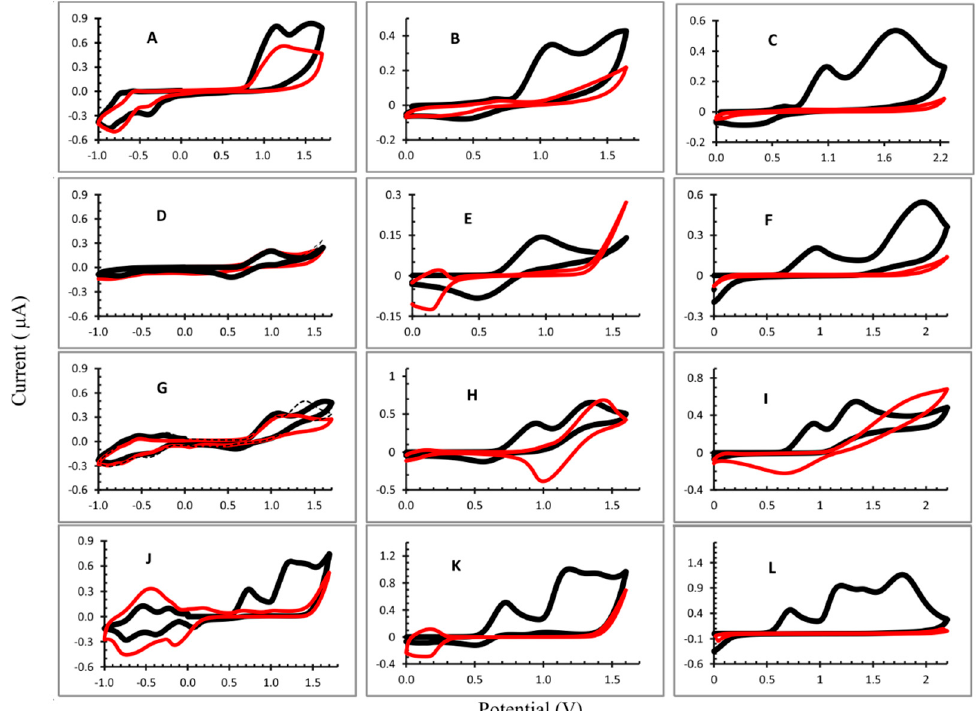
Figure 2. Cyclic voltammograms recorded during electropolymerization: ( A ) OEP 1 ; ( B ) OEP 2 ; ( C ) OEP 3 ; ( D ) CuOEP 1 ; ( E ) CuOEP 2 ; ( F ) CuOEP 3 ; ( G ) NiOEP 1 ; ( H ) Ni OEP 2 ; ( I ) Ni OEP 3 ; ( J ) ZnOEP 1 ; ( K ) ZnOEP 2 ; and ( L ) Zn OEP 3 . Potential range: 1 : − 1.0 V to 1.7 V; 2 : 0.0 V to 1.6 V; and 3 : 0.0 V to 2.2 V. 1,2-C 2 H 4 Cl 2 with 0.1 mol L − 1 TBAP and 4 mmol L − 1 bpy. Working electrode: ITO; scan rate: 0.1 V s − 1 . Black line: first cycle and red line: 25th cycle.